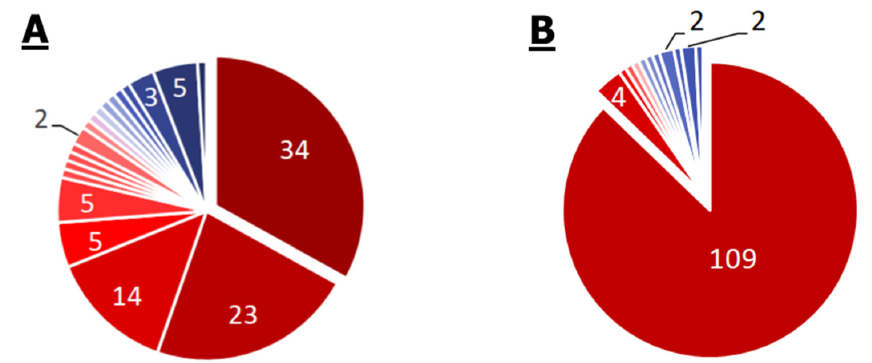
Figure 3. Pie chart of the proportion of annotations in the 35 genomes of Enterobacter spp. strains. Numbers depict annotations with equal frequency. Frequency—from 0.03 to 1—is presented in the color of slices on the scale from blue to red for distribution of modules ( A ) and pathways ( B ). Small slices without numbers correspond to the sole annotation with such frequency. There are no resistance modules among the 34 core modules, in 23 modules with frequency equal to 0.97, or in 14 modules with frequency equal to 0.94. They are only metabolic. Efflux pump AcrEF-TolC is present in 74% of genomes, the carbapenem resistance module in 31%, and the module of OmpF porin repression in 3% (only one strain). The rest of the modules are metabolic. Eighty-seven percent of pathways are present in every genome and 3% more are present in 97% of genomes.